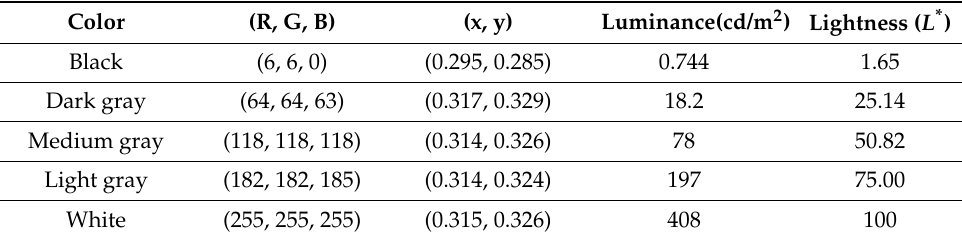
Table 2. Colorimetric characteristics of the five achromatic